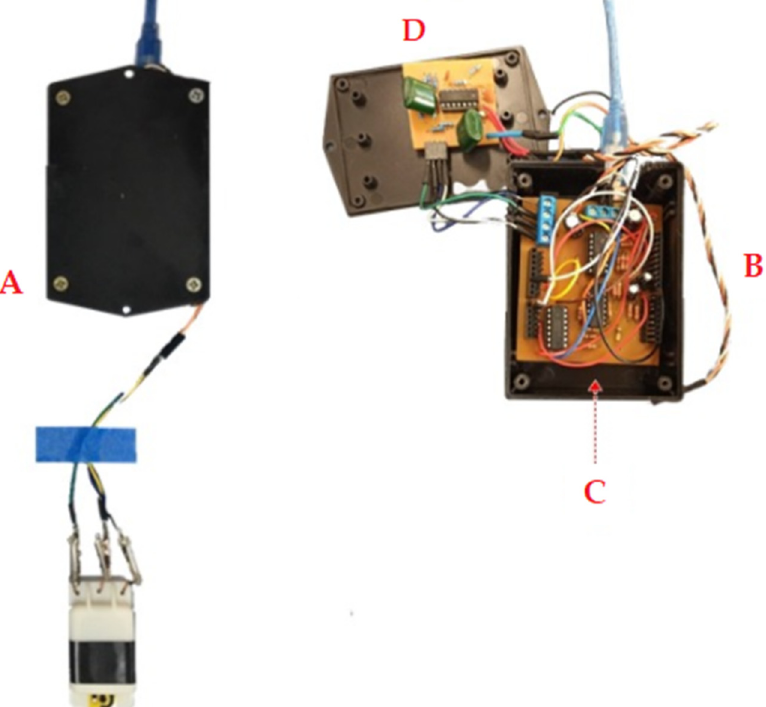
Figure 3. Image of our developed portable potentiostat. ( A ) Bottom view of the biosensor connected to the portable potentiostat, ( B ) Portable potentiostat pre-filter anti-aliasing; ( C ) Microcontrolled Platform; ( D ) Anti-aliasing filter. Platform; ( D ) Anti-aliasing